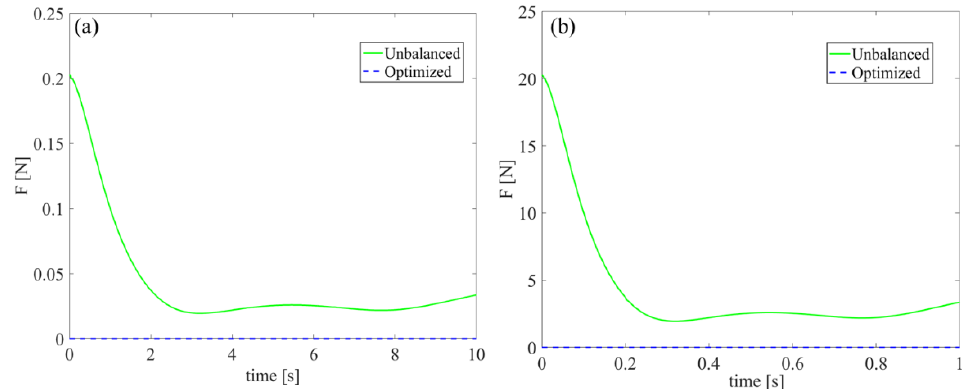
Figure 12. The shaking force of the unbalanced and optimized SPR at ( a ) “low” and ( b ) “high” for trajectory 2.